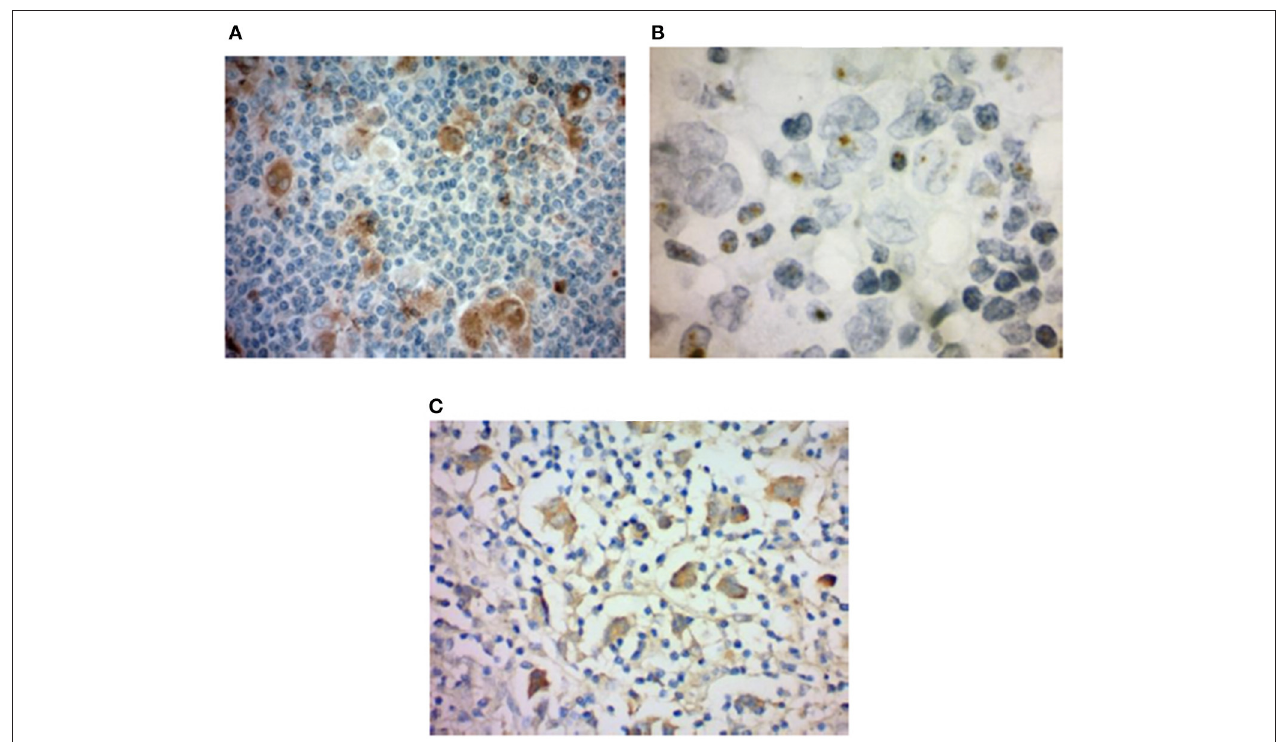
FIGURE 1 | HHV-6 in nodular sclerosis Hodgkin lymphoma. (A) Presence of HHV-6 p41 by immunohistochemistry. Cytoplasmic staining of numerous large cells using a monoclonal antibody to HHV-6 p41 (3E3 clone). (B) HHV-6 U94 detection by immunohistochemistry. Staining with monoclonal antibody to HHV-6 U94